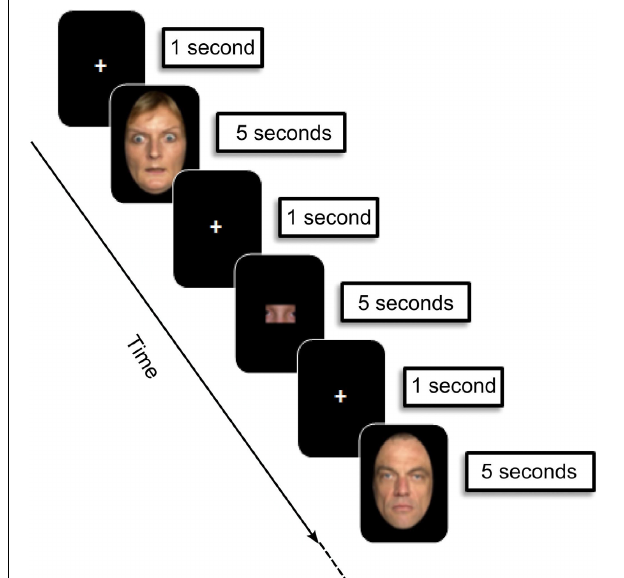
FIGURE 1 | Experimental design: encoding phase. During each trial (12s), children were asked to memorize faces presented (5s), preceded and followed by a fixation cross (1000ms). Then an image containing a “face part” was presented (5s), and children were asked to indicate whether or not it belonged to the face presented immediately before. Faces were selected from the FACES database (Ebner et al.,